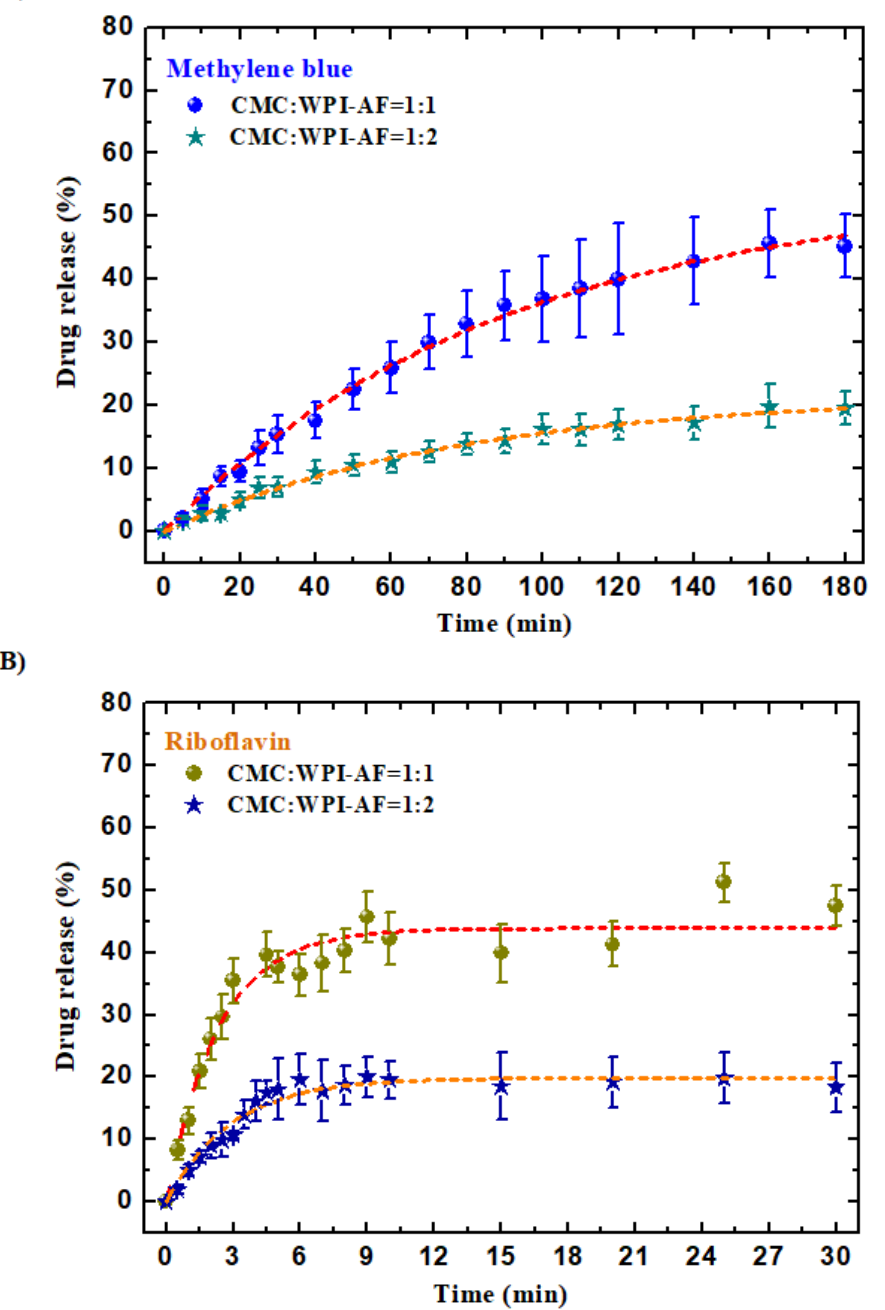
Figure 7. In vitro passive drug release curves of drugs from the CMC/WPI-AF membranes with different CMC:WPI-AF mass ratios (( A ) methylene blue and ( B ) riboflavin). The CMC:WPI-AF mass ratios used were 1:1 and 1:2. Table 2. Estimates of the first order model parameters for MB or RF release from CMC/WPI - AF membranes synthesized at CMC:WPI - AF mass ratios of 1:1 and 1:2. CMC/WPI-AF Membranes